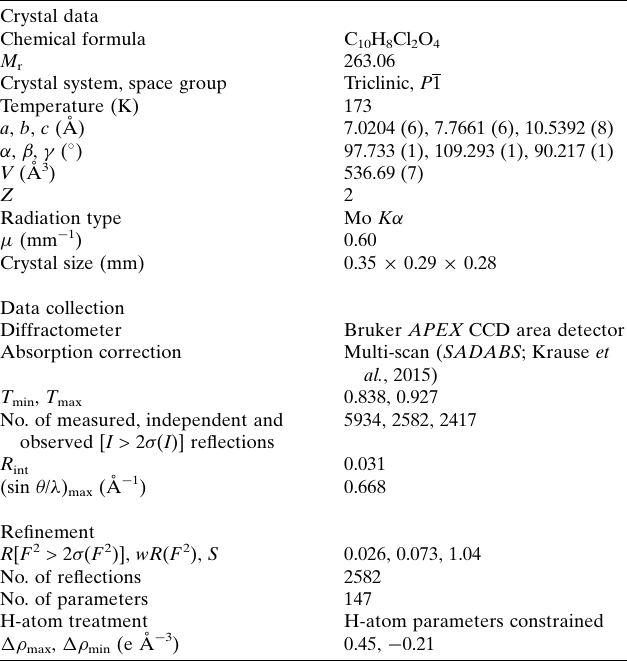
Table 2 Experimental details. Crystal data Chemical